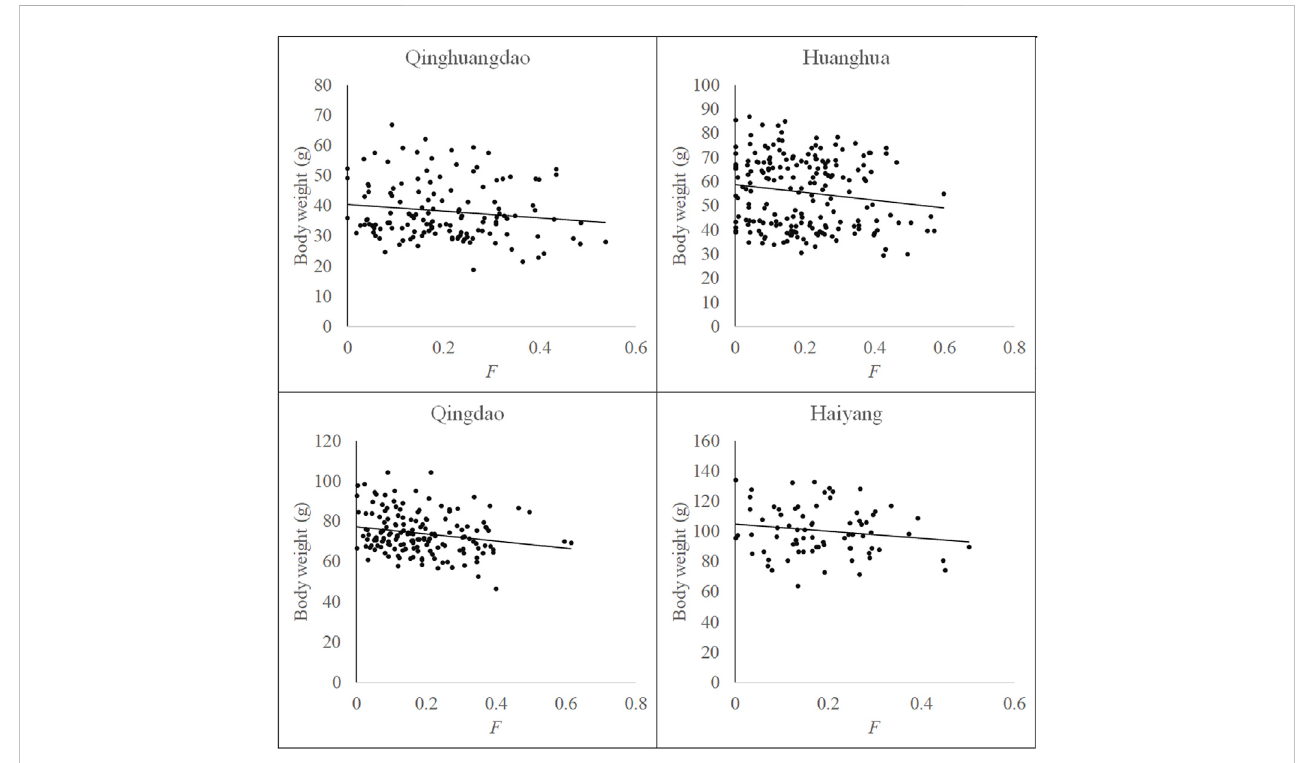
FIGURE 3 Relationship between F and body weight in each population.